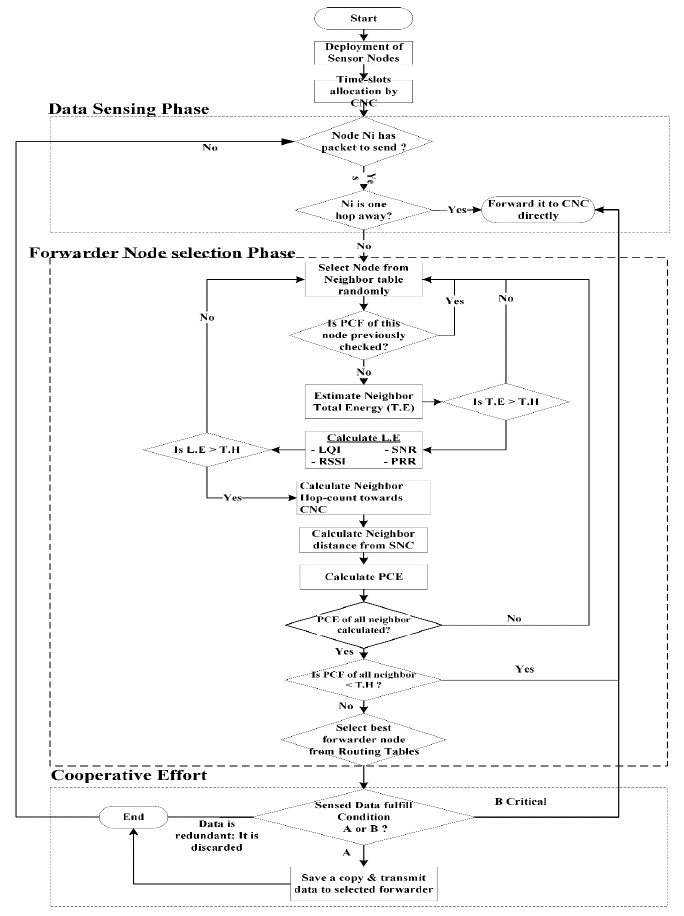
Figure 5. Flowchart of EHCRP.